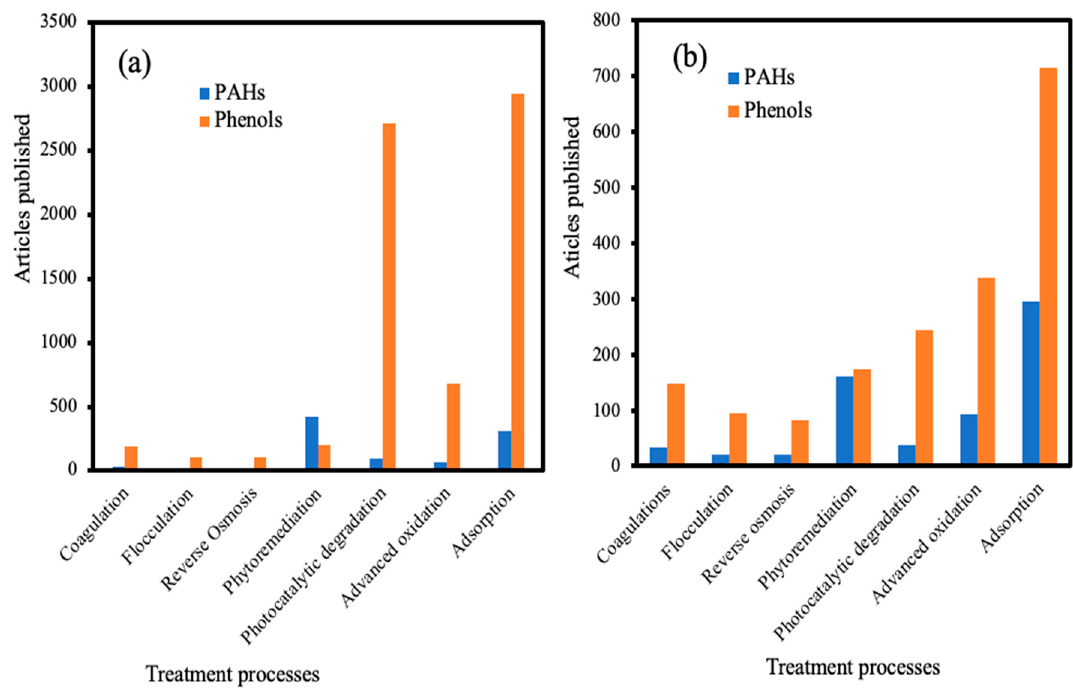
Figure 1. Trends of ( a ) publications and ( b ) patents on various treatment techniques for PAHs